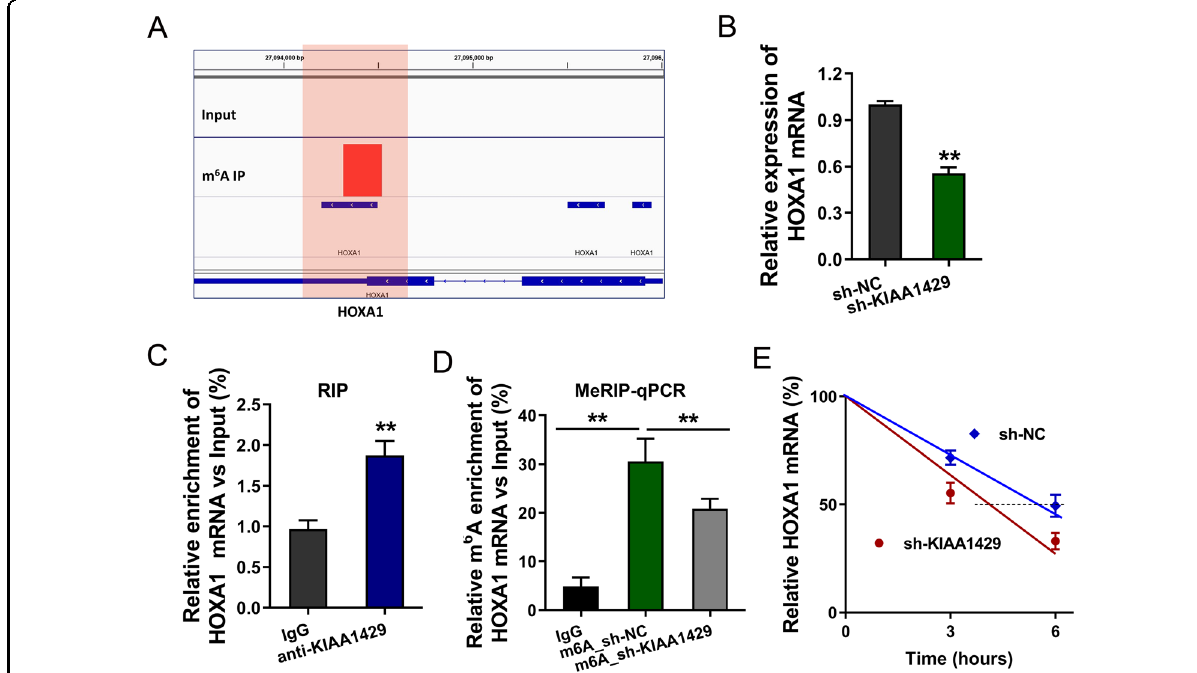
Fig. 4 KIAA1429 enhanced the stability of HOXA1 mRNA. A Integrative genomics viewer (IGV) tool showed the remarkable m 6 A peak in the 3 ′ - UTR of HOXA1 mRNA. B RT-qPCR was performed to detect the HOXA1 mRNA expression. C RNA-binding protein immunoprecipitation assay (RIP) demonstrated the interaction within KIAA1429 antibody (anti-KIAA1429) and m 6 A-modi fi ed HOXA1 mRNA. D MeRIP-qPCR with speci fi c primers (HOXA1 mRNA primer) revealed the m 6 A modi fi cation level upon KIAA1429 knockdown or control. E KIAA1429-knockdown PC9-GR cells or control cells were treated with actinomycin D (1 μ g/ml). The RNA decay rate was identi fi ed using qPCR normalized to initial 0-h expression. Bar graphs indicate the means ± SD. ** P <